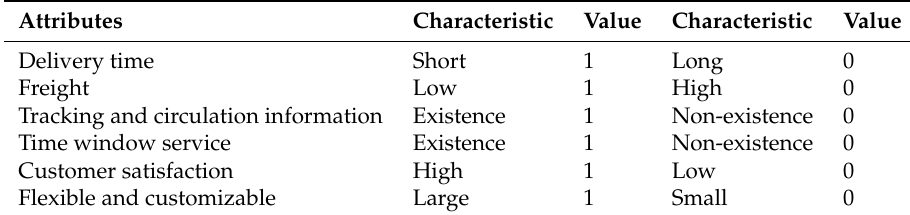
Table 3. Description of the attributes.